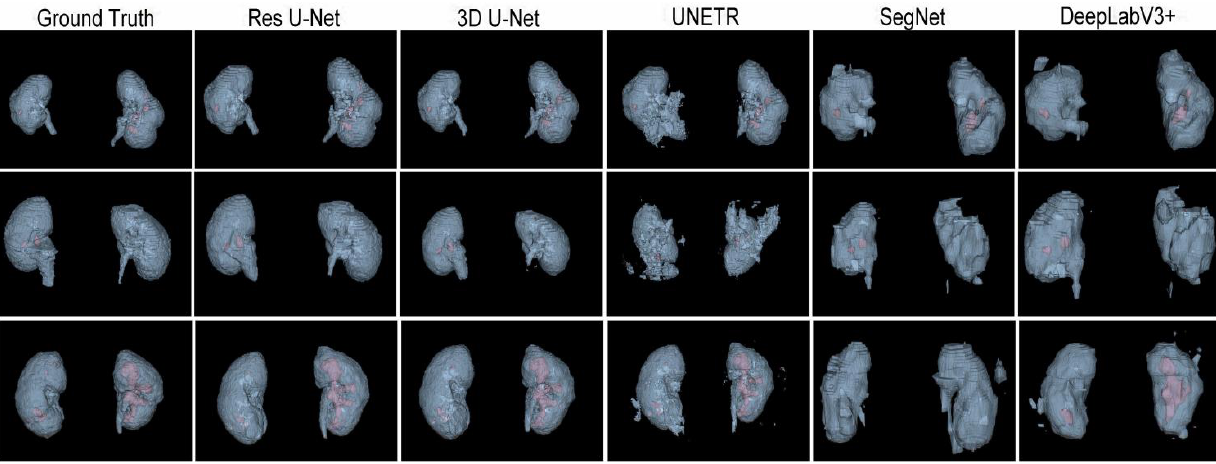
Figure 17. The 3D visual analysis of predictions generated by the models trained independently.